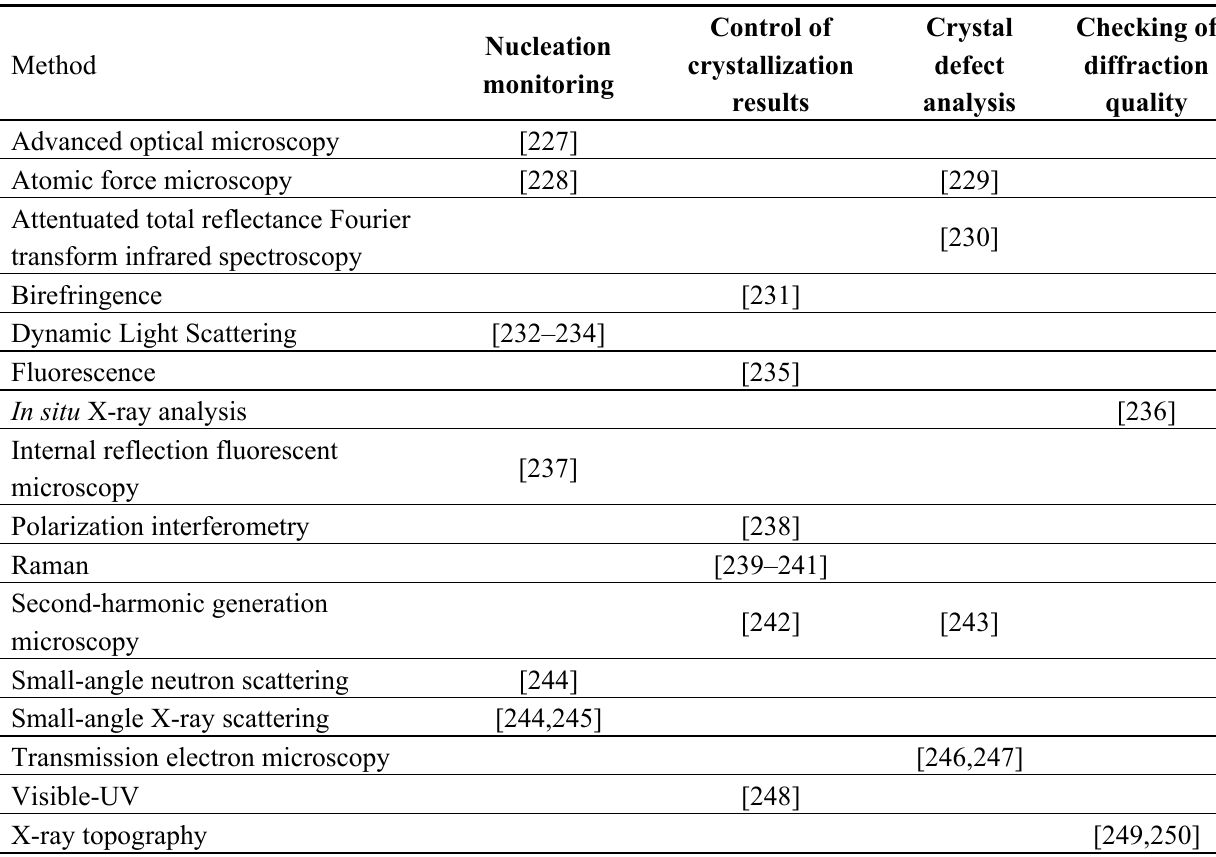
Table 4. Experimental methods used in monitoring and scoring crystallization